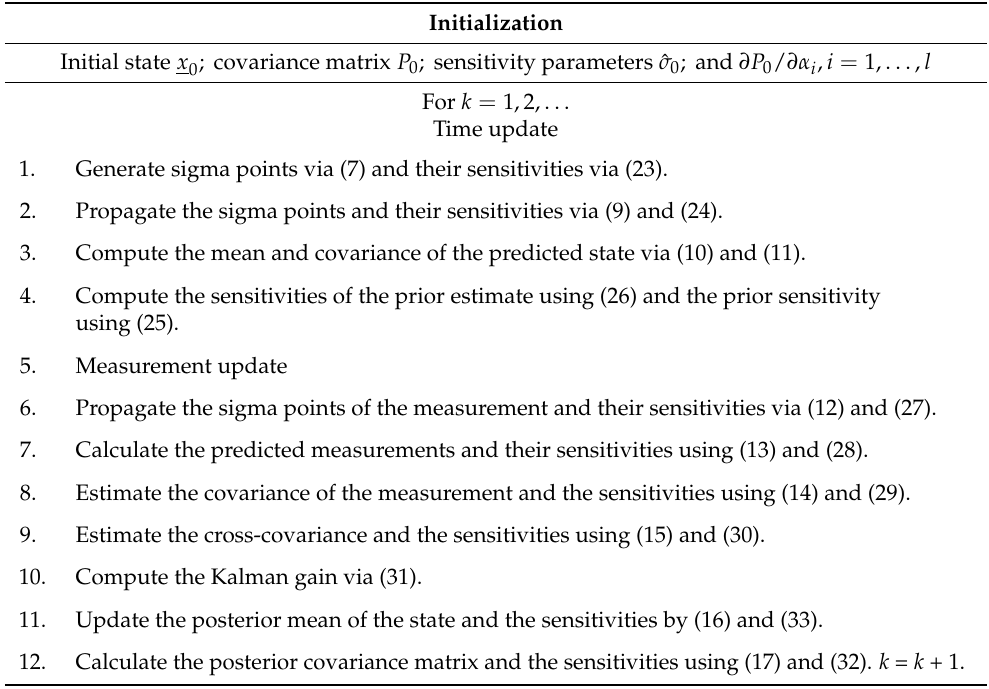
Table 1. Summary of the RDUKF approach for SOC